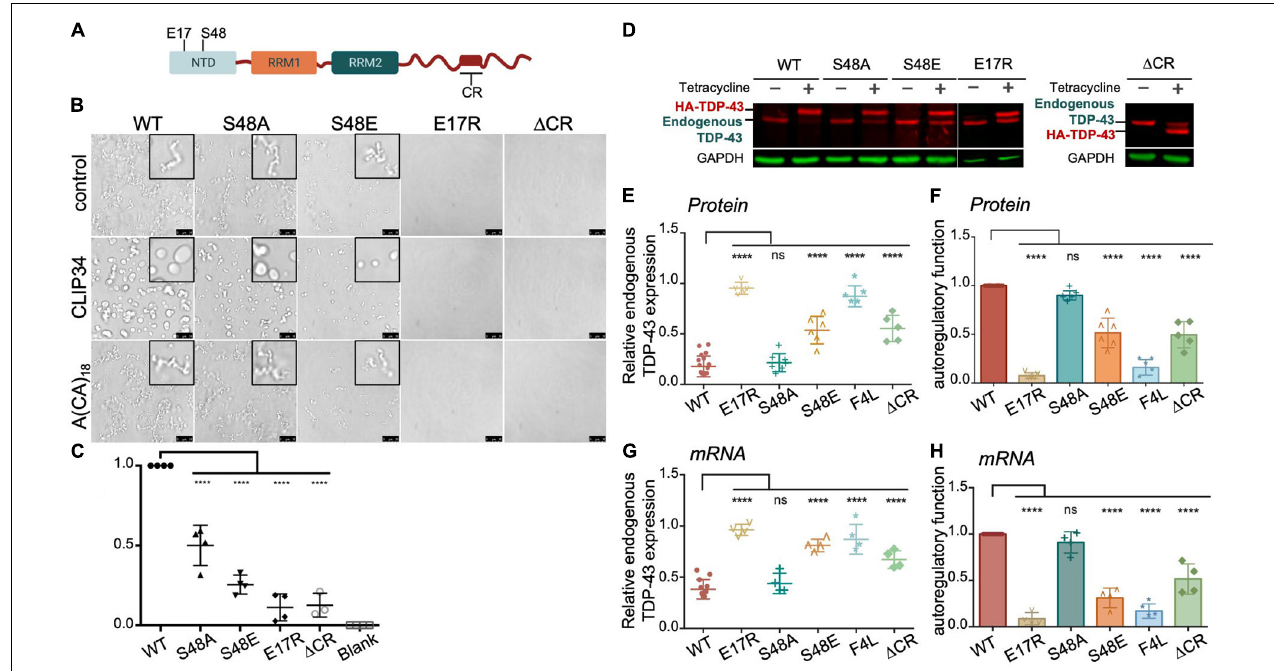
FIGURE 3 | TDP-43 autoregulation in human cells depends on protein self-assembly and phase separation. (A) Single site amino acid substitutions at E17 and S48 in the N-terminal domain of TDP-43 and deletion of the highly conserved region (CR) in the C-terminal domain are indicated. (B) Phase separation of purified WT and mutant TDP-43 (4.8 µ M) as seen by brightfield microscopy without RNA (control), in the presence of CLIP34 RNA (4.8 µ M), or the non-specific control RNA A(CA) 18 (4.8 µ M) at 150 mM NaCl, pH 7.5. Representative images of three biological replicates from 2 protein preparations. Scale bars, 10 µ m. (C) Phase separation of WT and mutant TDP-43 measured by turbidity in the same experimental conditions as panel (B) . Mean and SD of at least three biological replicates from 2 recombinant protein preparations. Analyzed by one-way ANOVA [ F (4,14) = 81.45, P < 0.0001]. Dunnett’s multiple comparisons test was used to compare groups to WT. **** P ≤ 0.0001. The last column corresponds to blank, buffer only sample. (D) Representative immunoblots of HEK293 cell lines stably expressing HA-tagged TDP-43 upon tetracycline induction for 72 h. Transgene and endogenous TDP-43 signals are indicated. Immunoblots were probed with TDP-43 antibody (red) and GAPDH as loading control (green). (E) Reduction of endogenous TDP-43 protein levels upon expression of the transgene quantified from panel (D) . Cells expressing the RNA binding-deficient mutant F4L were used for comparison. (F) Autoregulatory activity of each mutant, relative to WT, calculated from values in panel (E) as endogenous TDP-43 WT /endogenous TDP-43 mutant . (G,H) Autoregulation in terms of Tardbp transcript levels measured by qPCR and quantified as in panels (E,F) . Mean and SD of ≥ 5 and four biological replicates for protein and RNA, respectively. Analyzed by one-way ANOVA, (E) [ F (10,69) = 111.6, P < 0.0001], (F) [ F (11,58) = 75.02, P < 0.0001], (G) [ F (10,43) = 54.64, P < 0.0001] and (H) [ F (9,37) = 97.40, P < 0.0001]. Dunnett’s multiple comparisons test was used to compare selected groups. **** P ≤